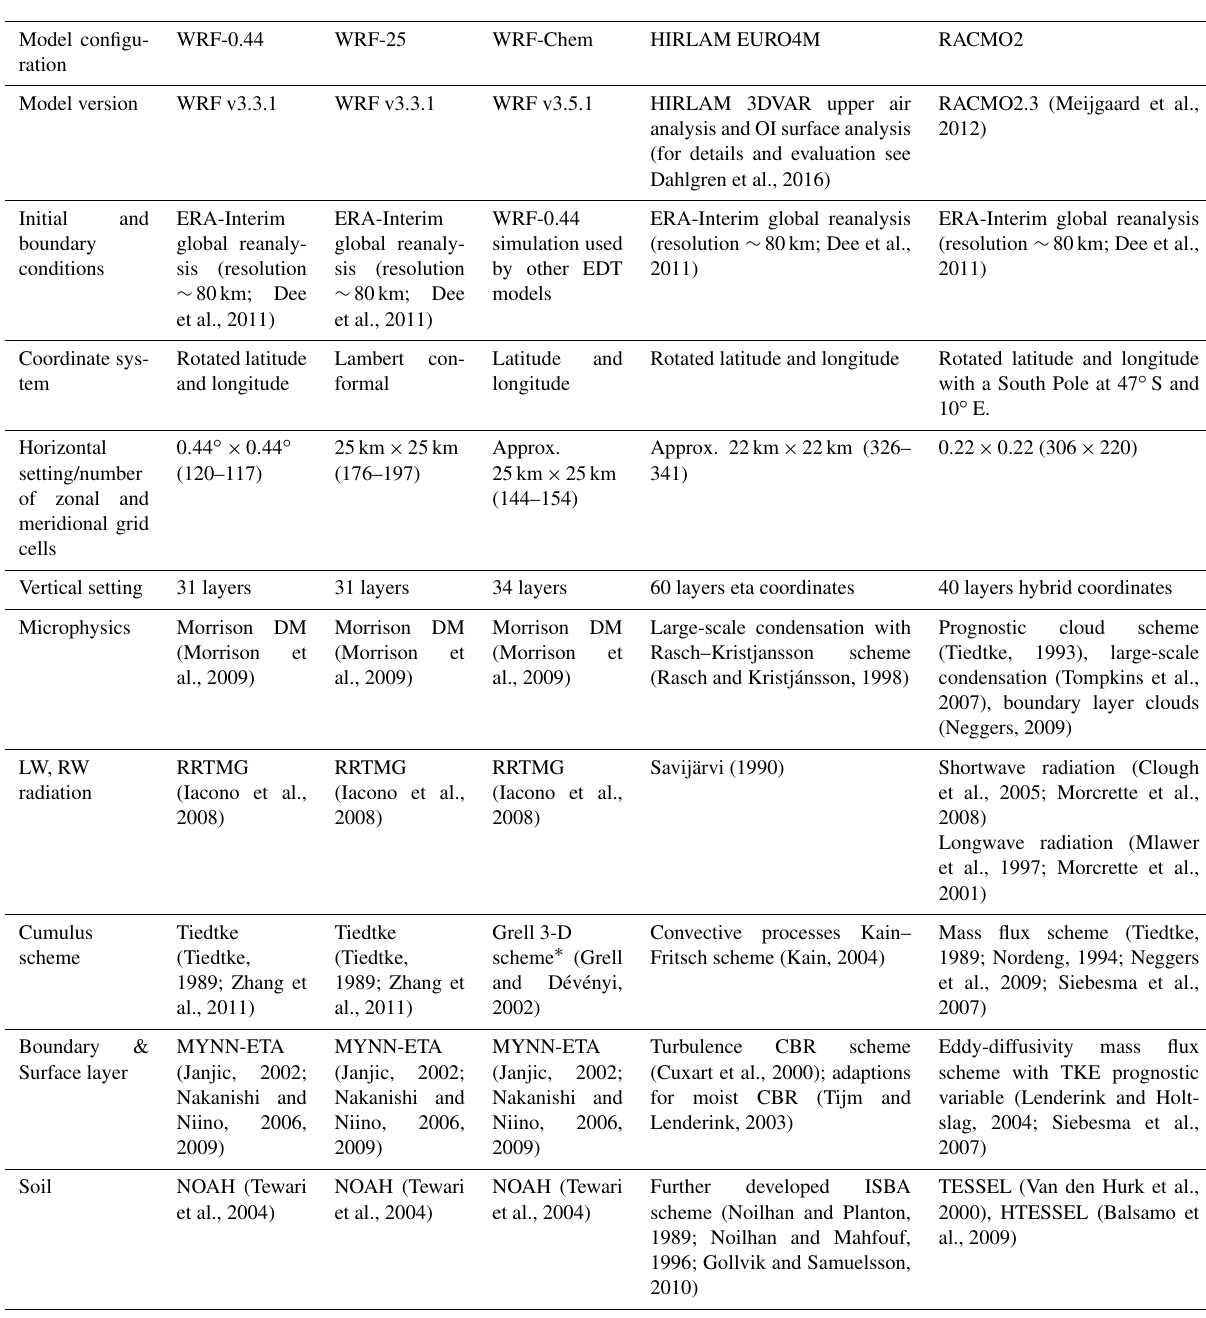
Table 4. Meteorological fields used in the EDT project. WRF-0.44 corresponds an optimised and nudged version of the WRF-IPSL-INERIS Eurocordex member at 0.44 ◦ from the EuroCordex climate downscaling programme (Jacob et al., 2013) used by most CTMs in EDT. WRF-25 corresponds to the WRF run in the same condition as WRF-0.44 in a Lambert conformal conic projection used to drive CMAQB. WRF-Chem indicates the configuration of WRF used within the WRF-Chem online CTM. RACMO2 is the meteorological model used by